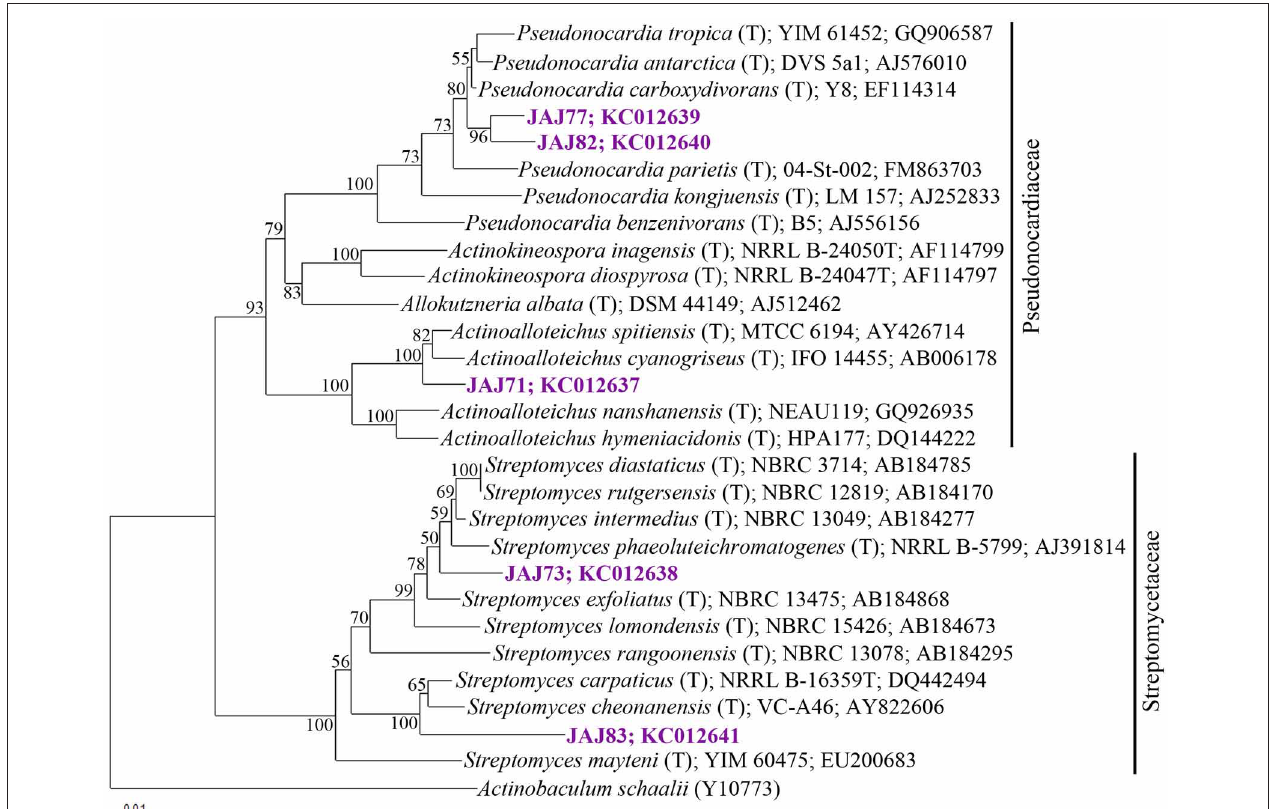
FIGURE 4 | Neighbor-joining tree based on 16S rRNA gene sequences of selected isolates from inland solar salterns, showing the phylogenetic relationship of isolates and related genera. Bootstrap values are expressed